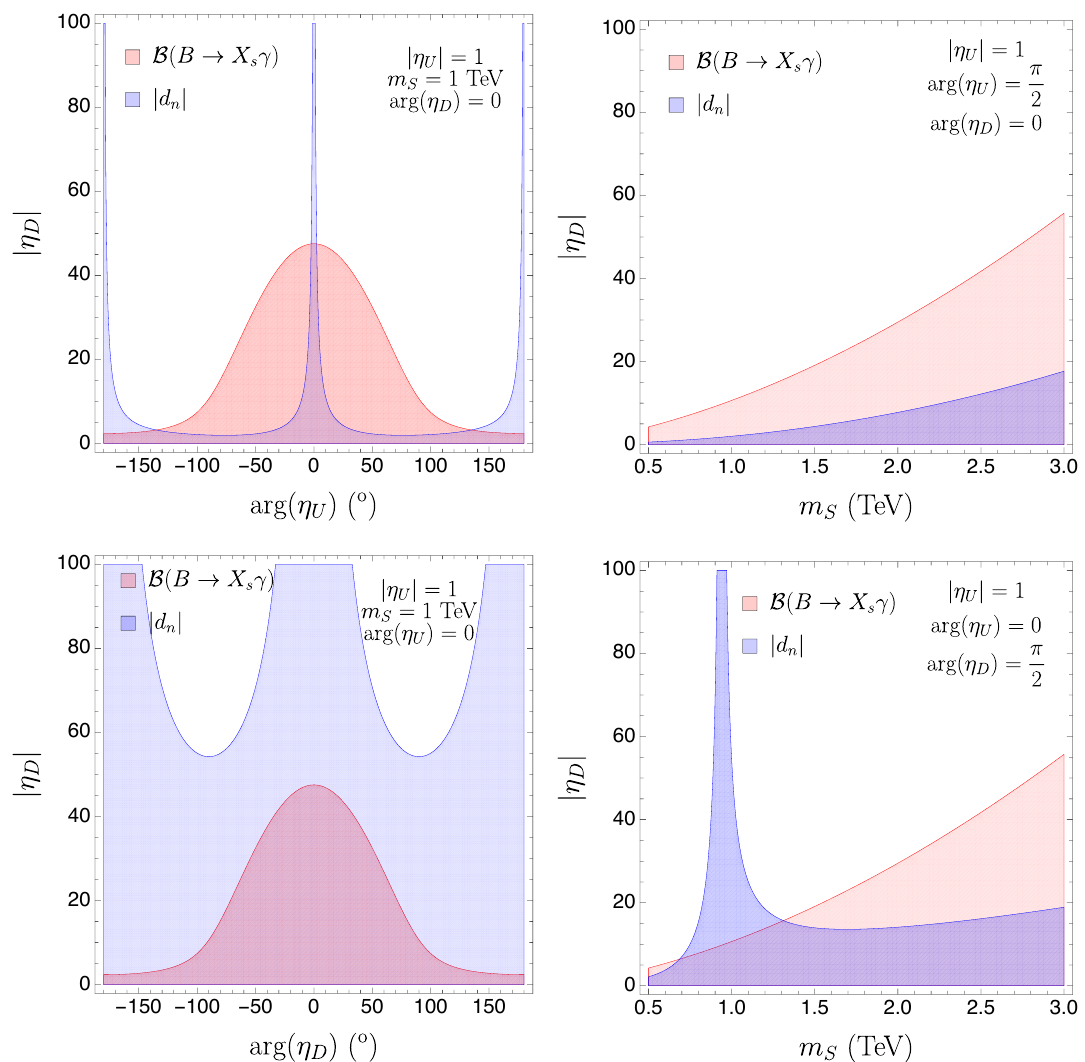
Figure 11 . Constraints on the parameter space of the MW model from the limits on the neutron EDM (blue) compared to those from B ( B → X s γ ) (red), calculated in ref. [26]. The coloured areas represent the allowed regions of parameter space. In the top panels one can see the large impact of the new EDM bounds on some regions of the parameter space. However, its restrictive power is diminished either when the absolute value of the Yukawa couplings is small enough, when the phases are arg( η U,D ) ≈ 0 , ± π , or in the presence of cancellation effects as in m S ≈ 1 TeV (see text for